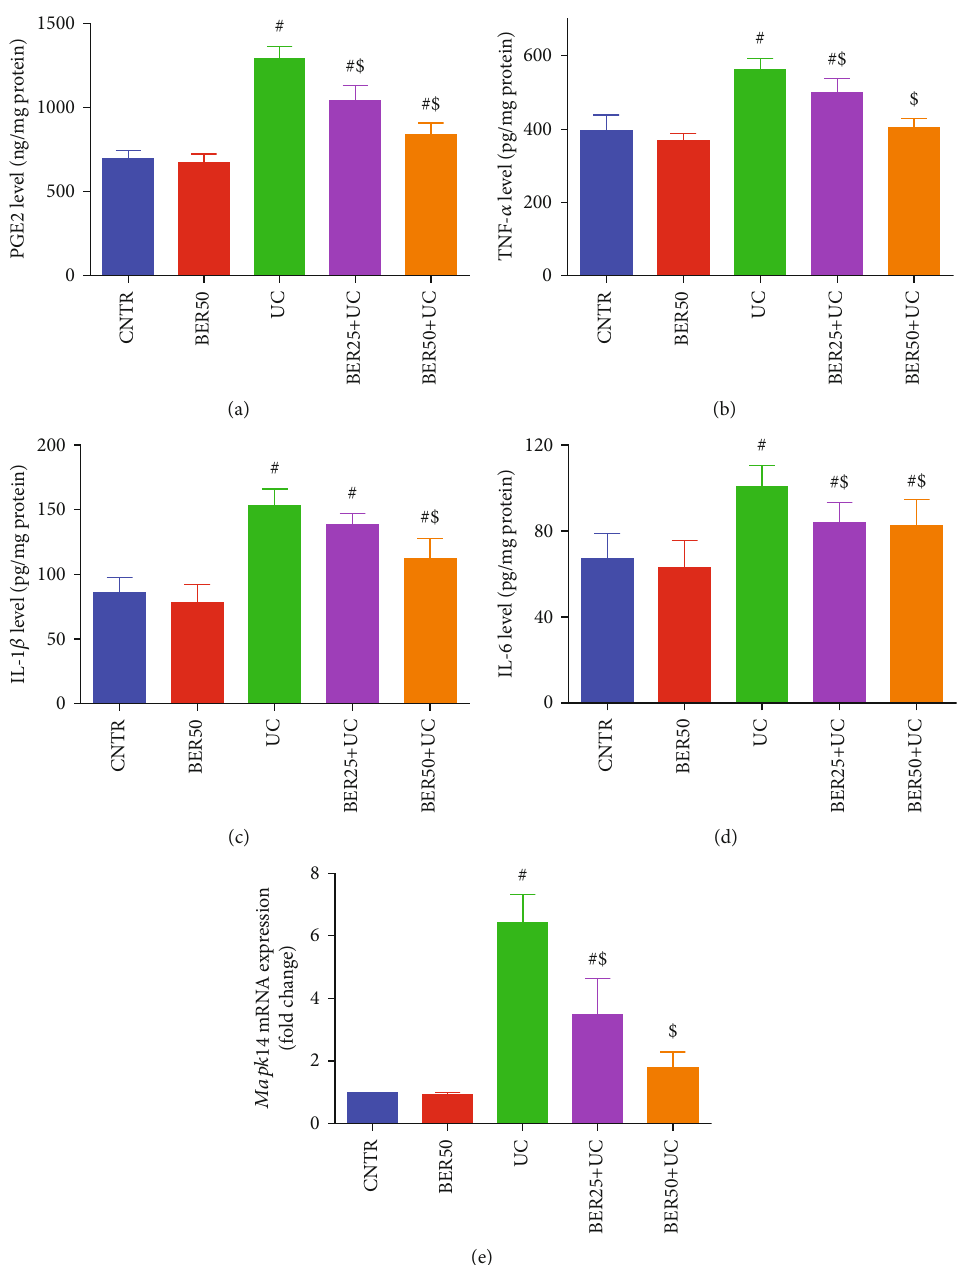
Figure 6: E ff ect of berberine at di ff erent doses on in fl ammatory mediators and cytokines ((a) PGE2, (b) TNF- α , (c) IL-1 β , and (d) IL-6) and (e) Mapk14 mRNA expression in colonic tissue of experimental colitis in rats. The results are expressed as the mean ± SD ( n = 7 ). qRT-PCR results of Mapk14 were normalized with Gapdh and represented as fold change as compared to mRNA levels in the CNTR rats. # p < 0 : 05 compared to the CNTR group (intact group); $ p < 0 : 05 compared to UC-untreated